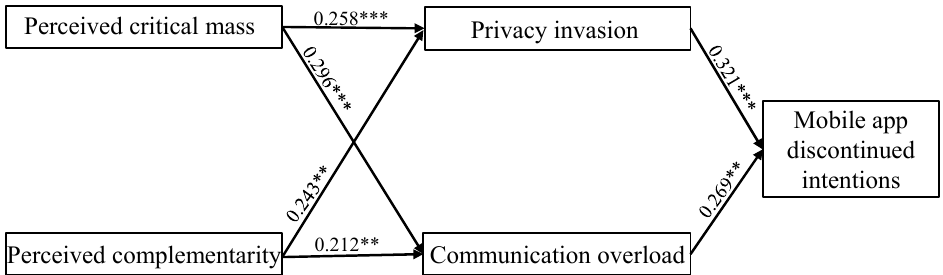
Figure 2. Path analysis result of the structural model. Note: ** p < 0.01; *** p < 0.001.